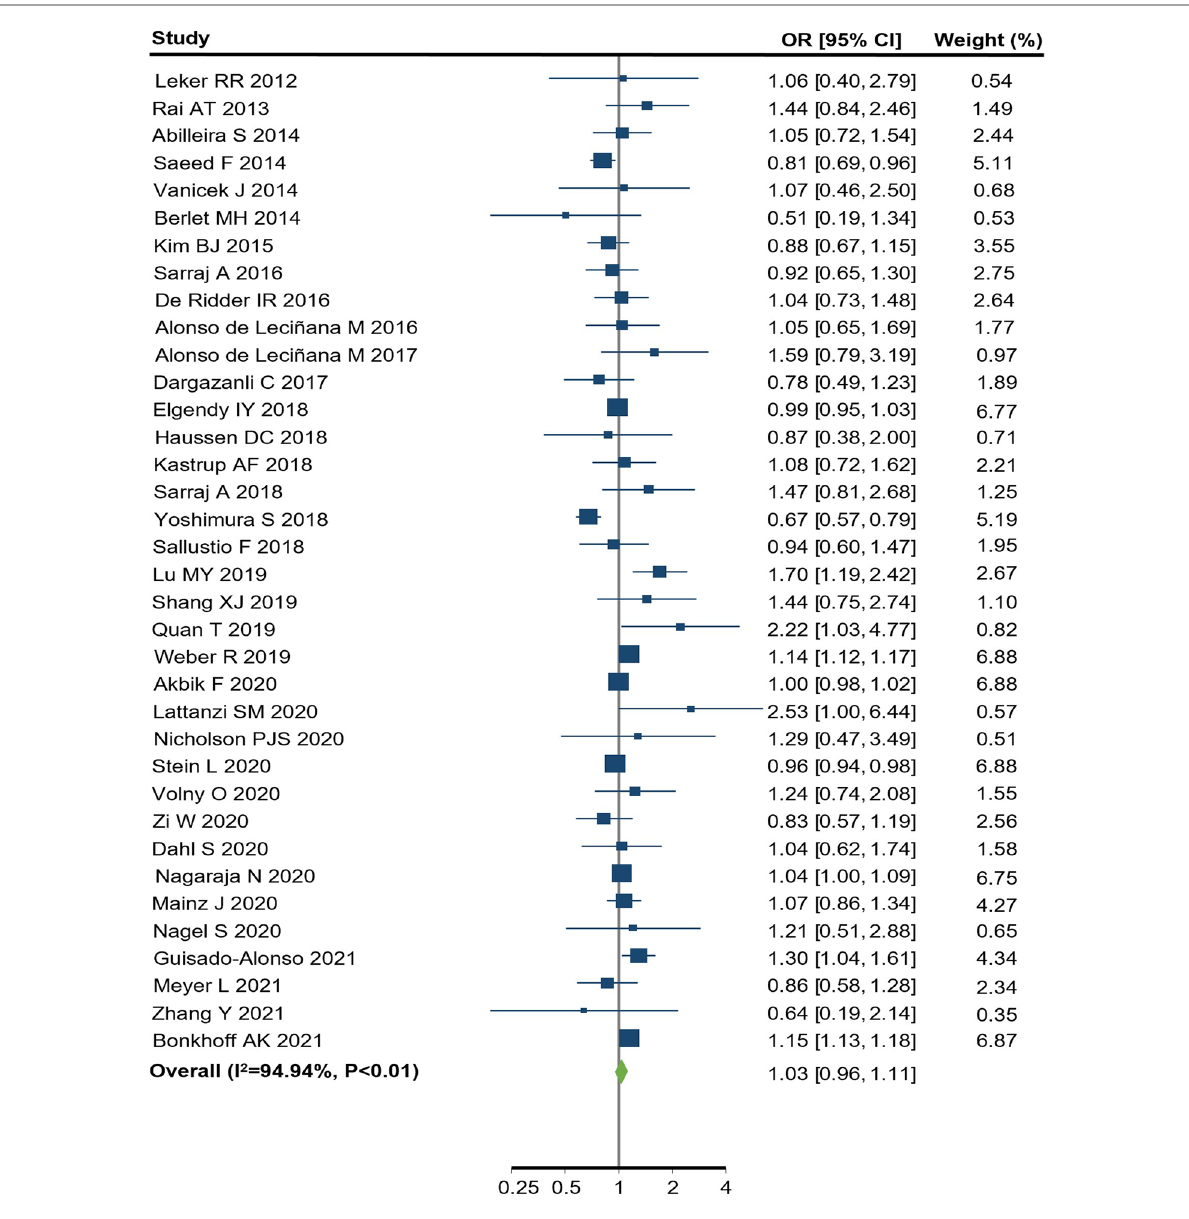
FIGURE 2 endovascular treatment use for women compared to men in observational studies. CI, con fi dence interval; OR, odds ratio. p value from Q